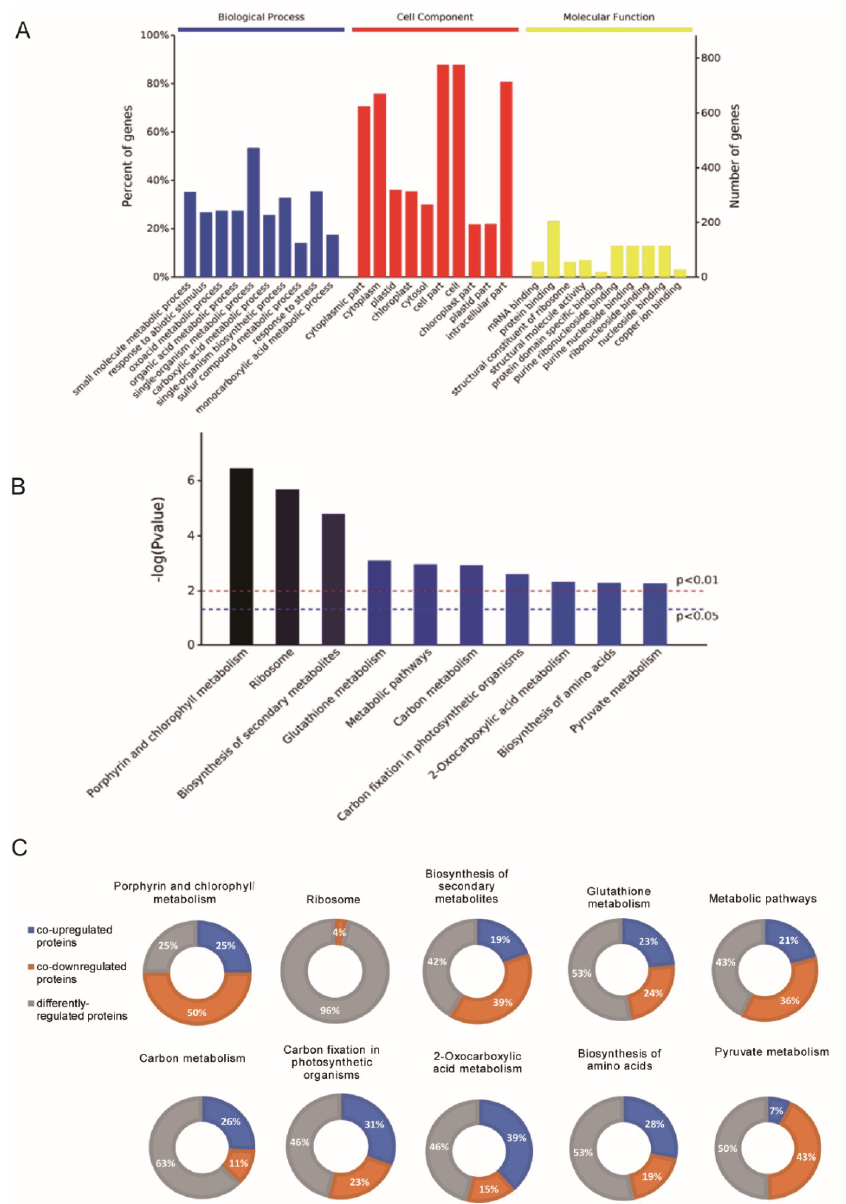
Figure 3. Summary of temperature stress-responsive proteins under LT and HT treatments. ( A ) Histogram presentation of Gene Ontology (GO) classification of 1,022 commonly regulated proteins under LT and HT treatments. ( B ) Kyoto Encyclopedia of Genes and Genomes (KEGG) pathways of 1,022 commonly regulated proteins. ( C ) Percentage of the 1022 differentially regulated proteins that were co-upregulated (i.e., upregulated under both LT and HT), co-downregulated (i.e., downregulated under both LT and HT), and differently regulated (upregulated in response to one temperature treatment but downregulated in response to the other) in each KEGG pathway.